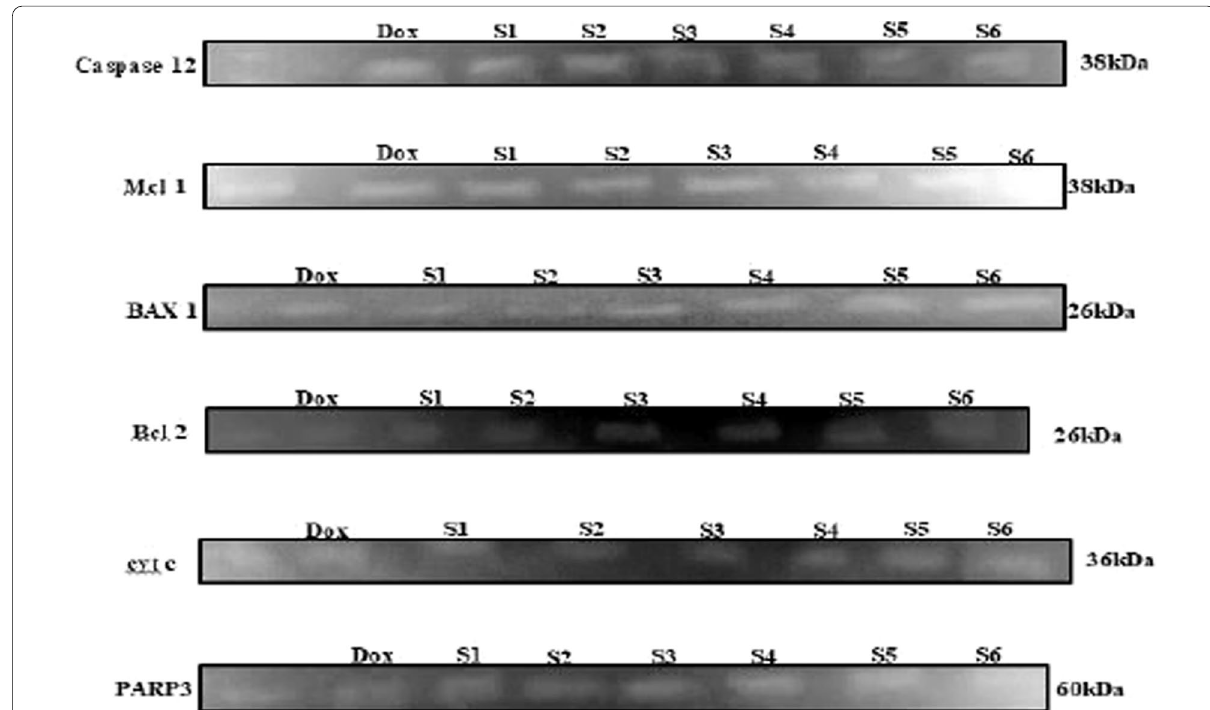
Fig. 5 Gel 1—Expression of apoptotic proteins with respective positive bands at 38 kDa for Caspase 12, 38 kDa for Mcl 1, 26 kDa for BAX, 26 kDa for Bcl 2, 36 kDa for cyt c, 60 kDa for PARP3, Dox—Doxorubicin , S1—NC4, S2—NC5, S3—NC6, S4—NP1, S5—NP6 Dox, S6—Chit-ND1